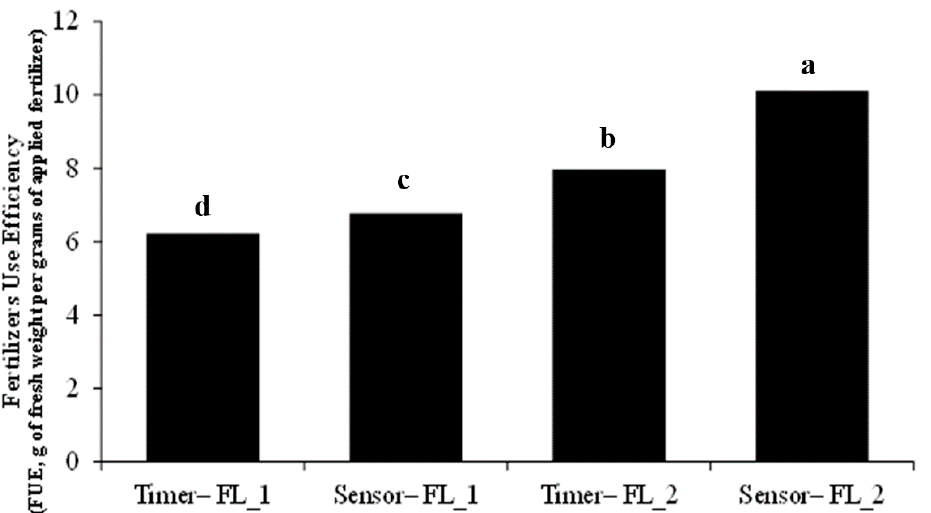
Figure 3. Fertilizer use efficiency (FUE), of greenhouse soilless rocket ( Diplotaxis tenuifolia L.) subjected to different irrigation strategies (timer-based or sensor-based) and two fertilization levels (FL_1, high fertilization level; FL_2 low fertilization level). “Irrigation management strategy × Fertilization level” interaction significant at p < 0.001. Different letters above the columns indicate significant difference between the treatments ( p < 0.05, means separation performed with SNK test).